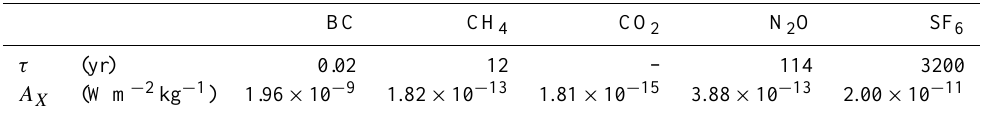
Table 1. Lifetime and radiative efficiency of BC, CH 4 , CO 2 , N 2 O, and SF 6 (see Forster et al., 2007, and Fuglestvedt et al., 2010). For the lifetime of CO 2 , see Table